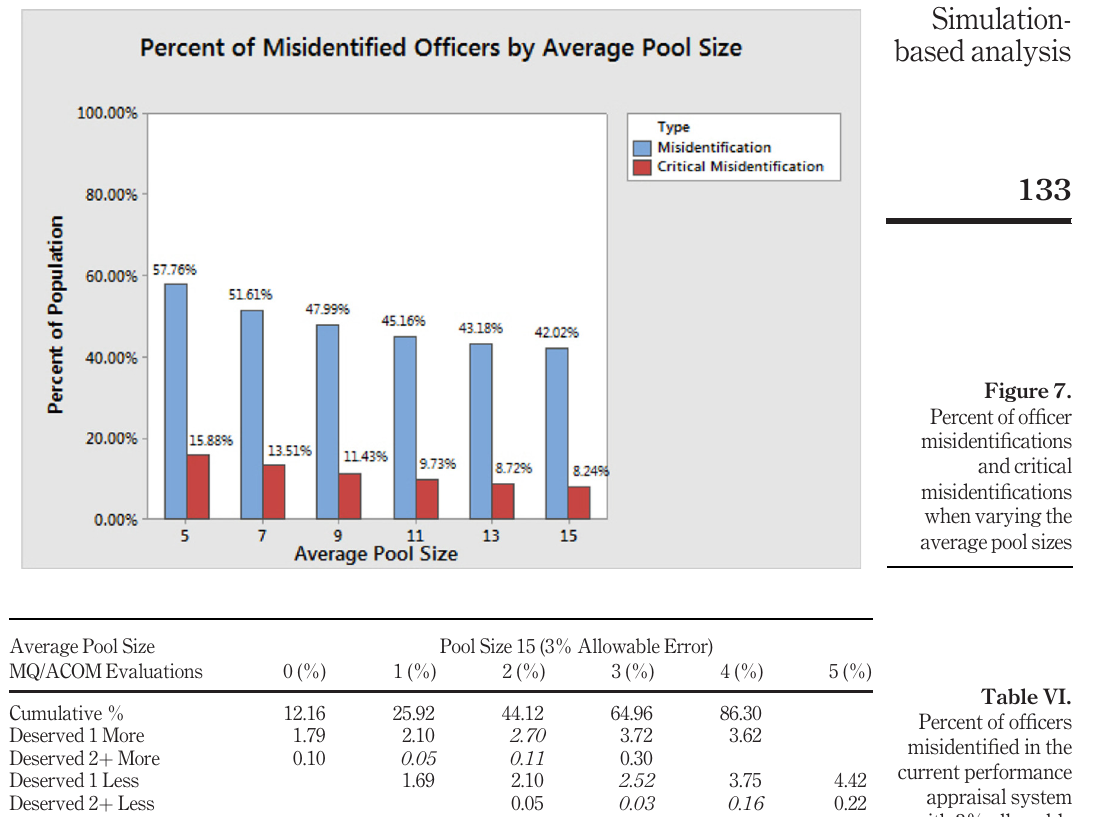
Table VI. Percent of of fi cers misidenti fi ed in the current performance appraisal